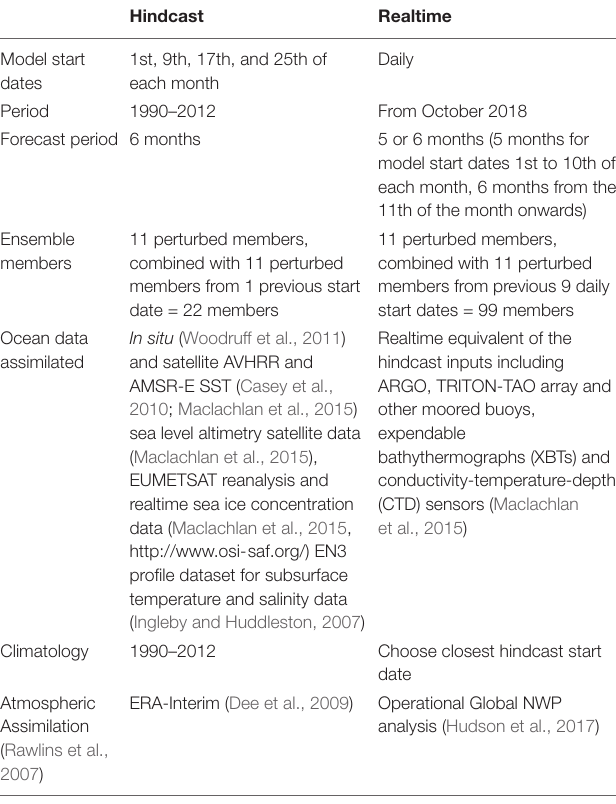
TABLE 1 | Summary of the ACCESS-S1 realtime and hindcast systems in terms of monthly ocean forecasts. Hindcast